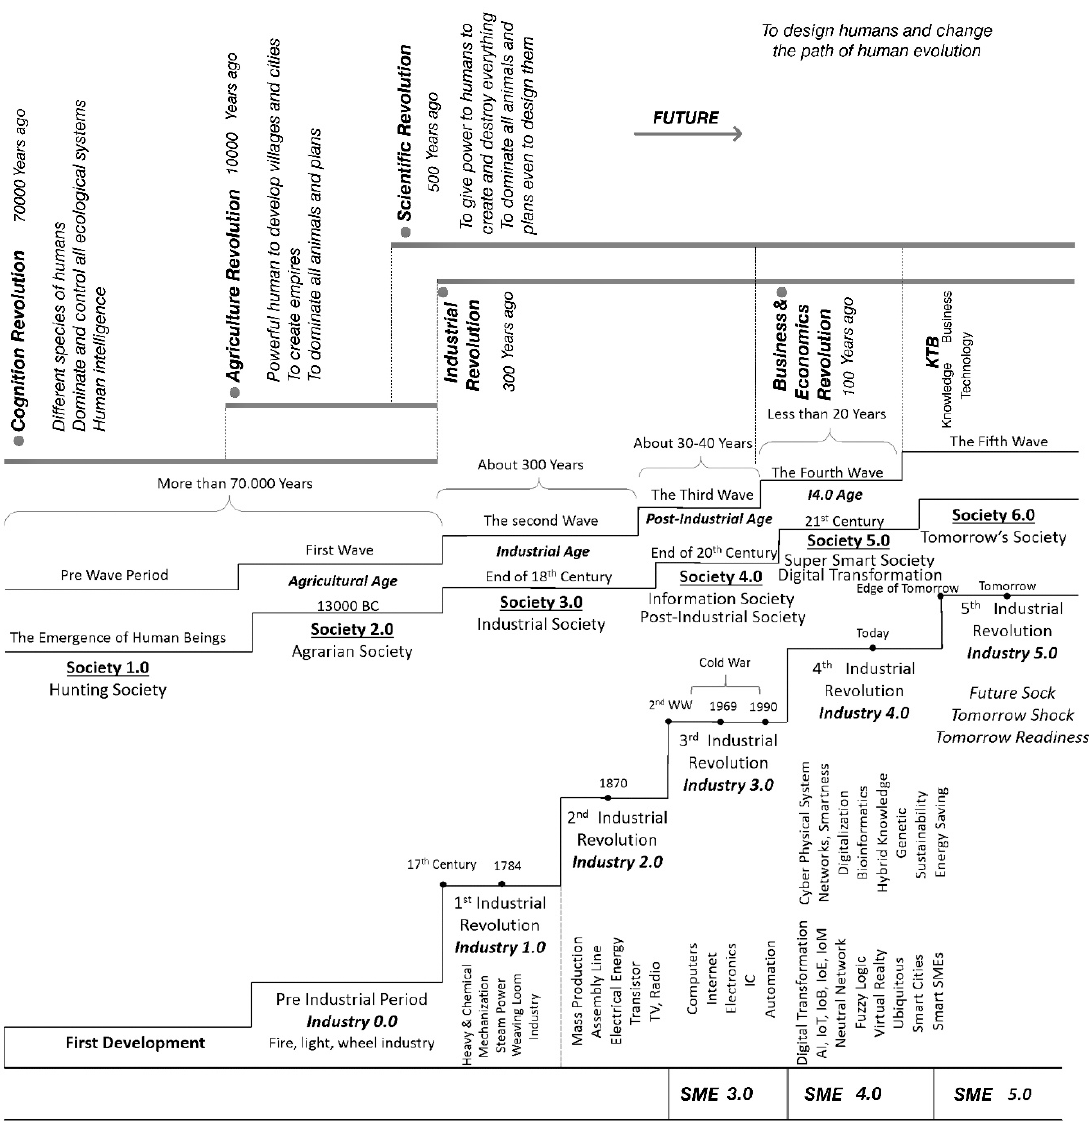
Figure 4. The 5th wave Theory, Ages and Technologies [8].